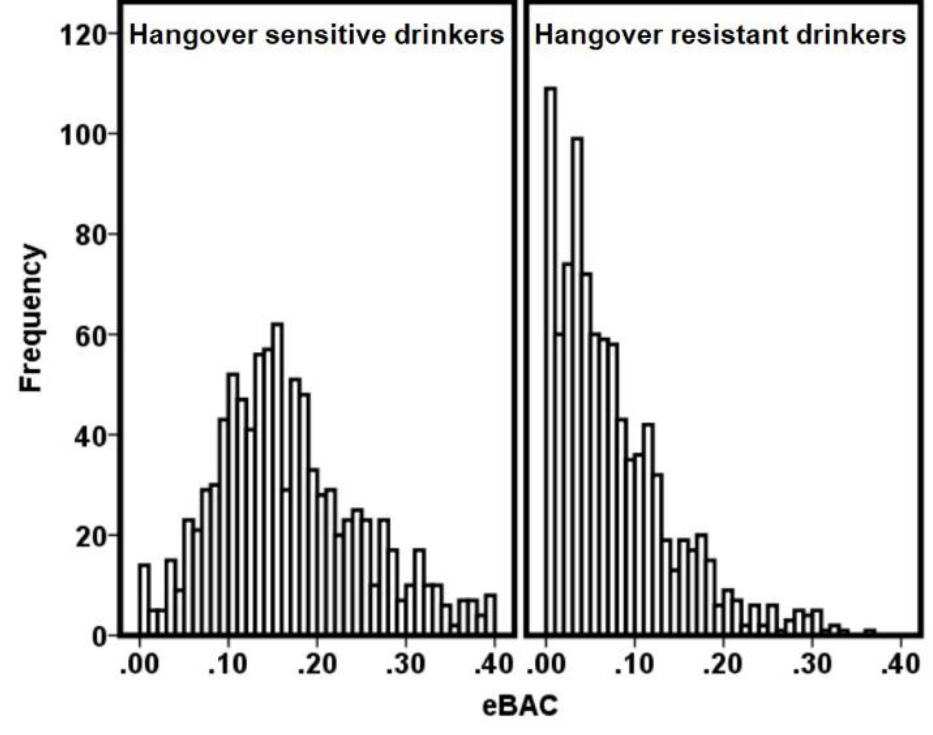
Figure 1. The number of hangover-sensitive and hangover-resistant drinkers at different eBAC levels. Abbreviation: eBAC = estimated blood alcohol concentration.